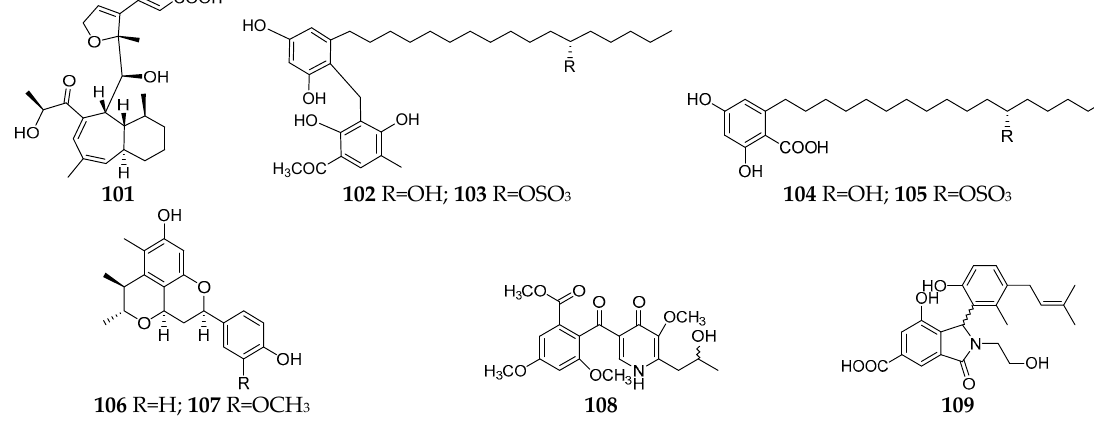
Figure 6. New SMs ( 101 – 109 ) isolated from fungal–fungal co-cultures using PDA.